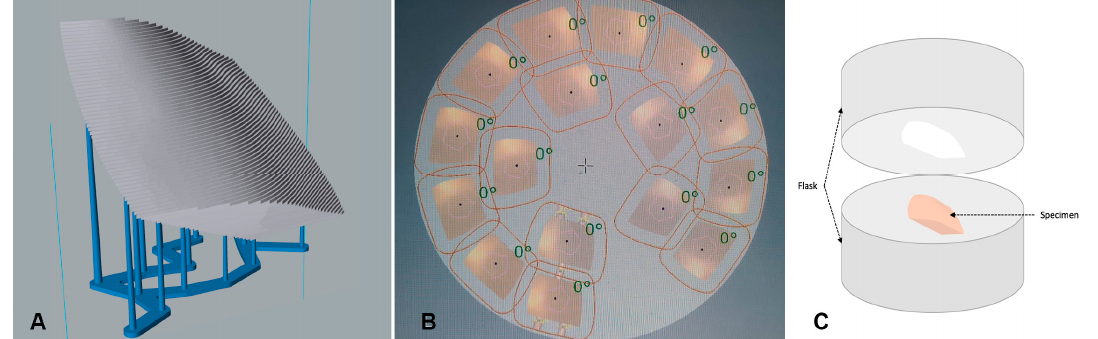
Figure 2. The manufacture of specimens in the ( A ) 3D-printed group, ( B ) milled group, and ( C ) con- ventional group. ( A ) The 3D-printed group, where the stair-stepping phenomena is evident on the fitting surface of the denture as a result of the manufacture layering process and the attachment of support structures to the opposite surface, representing the polished surface of the denture. ( B ) The milled specimens nested within the milling resin disc. ( C ) The conventional technique, where the specimen is invested for the flasking